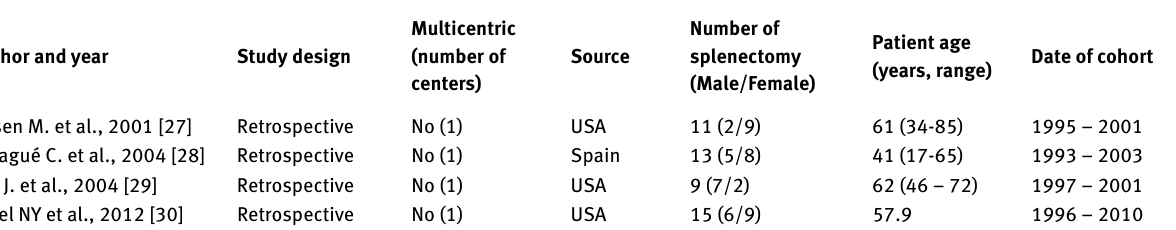
Table 3: Baseline characteristics of included studies